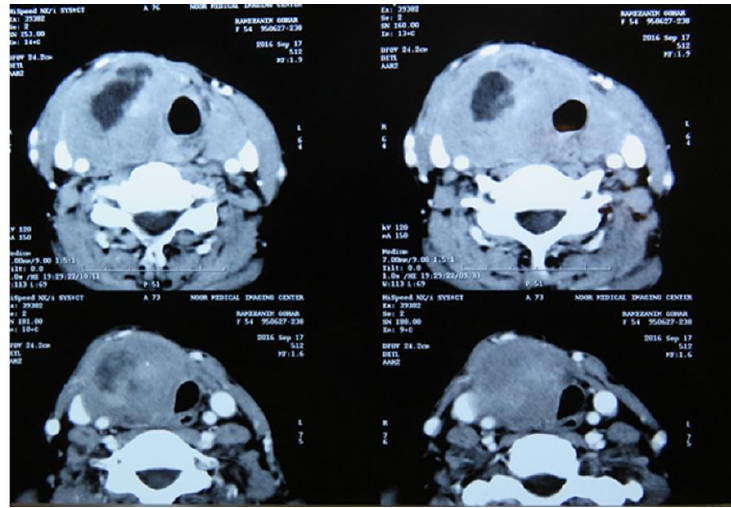
Figure 1. Illustrates the neck computerized tomographic (CT)